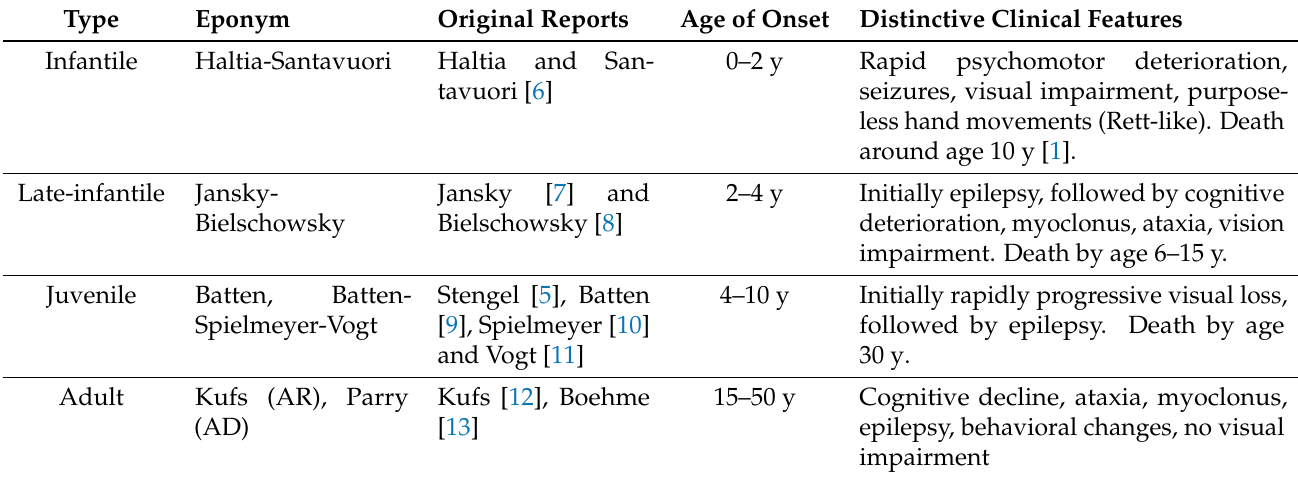
Table 1. Classic NCL types [4]. Of note, the very first researcher to describe the disease in 1826, Stengel [5], remains unrecognized. AR, autosomal recessive; AD, autosomal